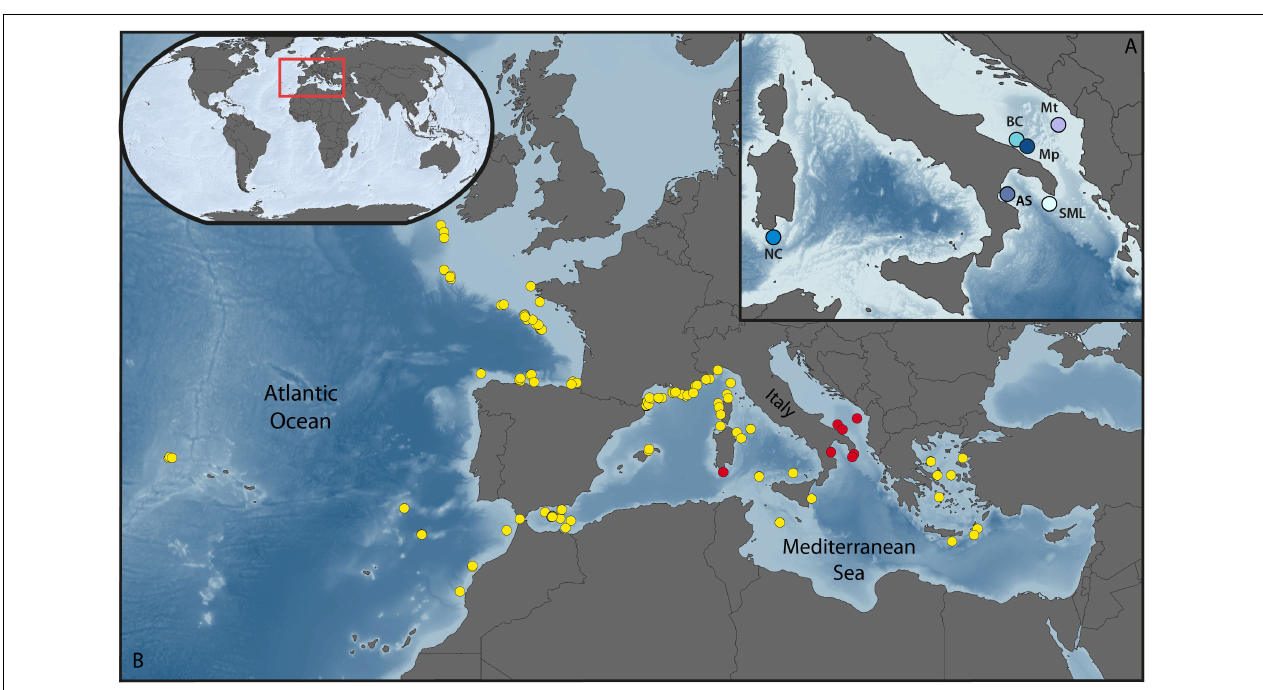
FIGURE 1 | Dendrophyllia cornigera distribution. (A) Detailed view of the sites explored by the ROV dives. BC, Bari Canyon (272–510 m depth); SML, off Santa Maria di Leuca (119–498 m depth); AS, Amendolara Seamount (133–205 m depth); NC, Nora Canyon (441–463 m depth); Mt, off Montenegro (433–504 m depth); Mp, off Monopoli (463–494 m depth). (B) Locations of D. cornigera published records (yellow dots, for reference see Supplementary Table S1 ), and occurrences obtained from ROV video transects (red